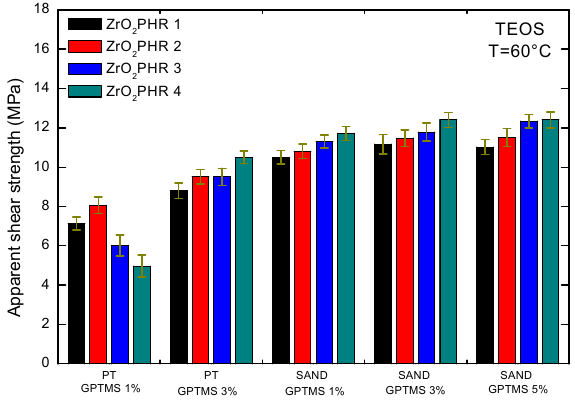
Figure 16. Apparent shear strength with different surface treatments of aluminum specimens.